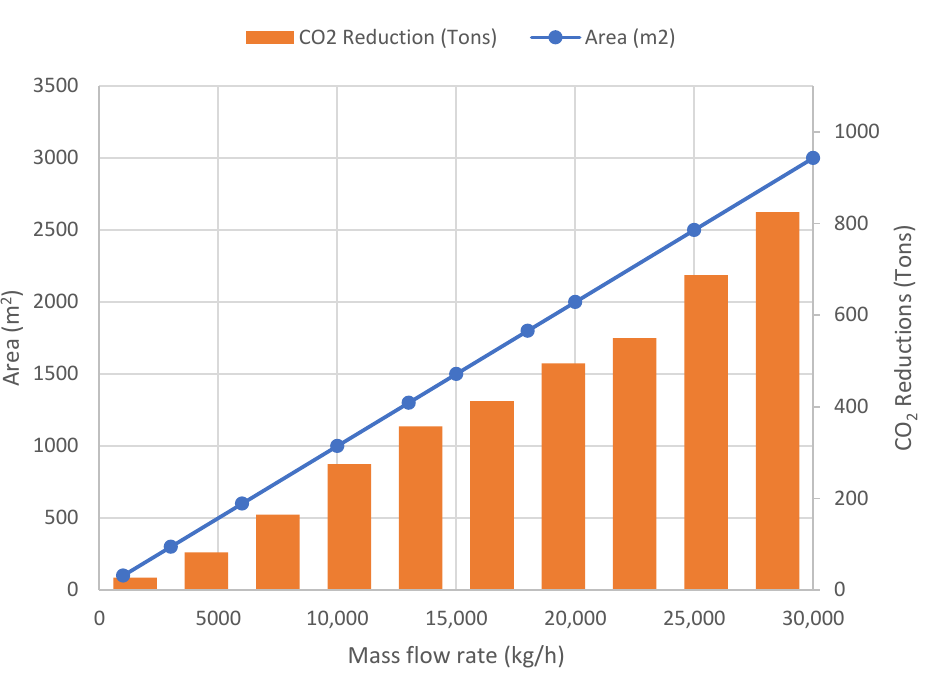
Figure 9. CO 2 reductions per annum.